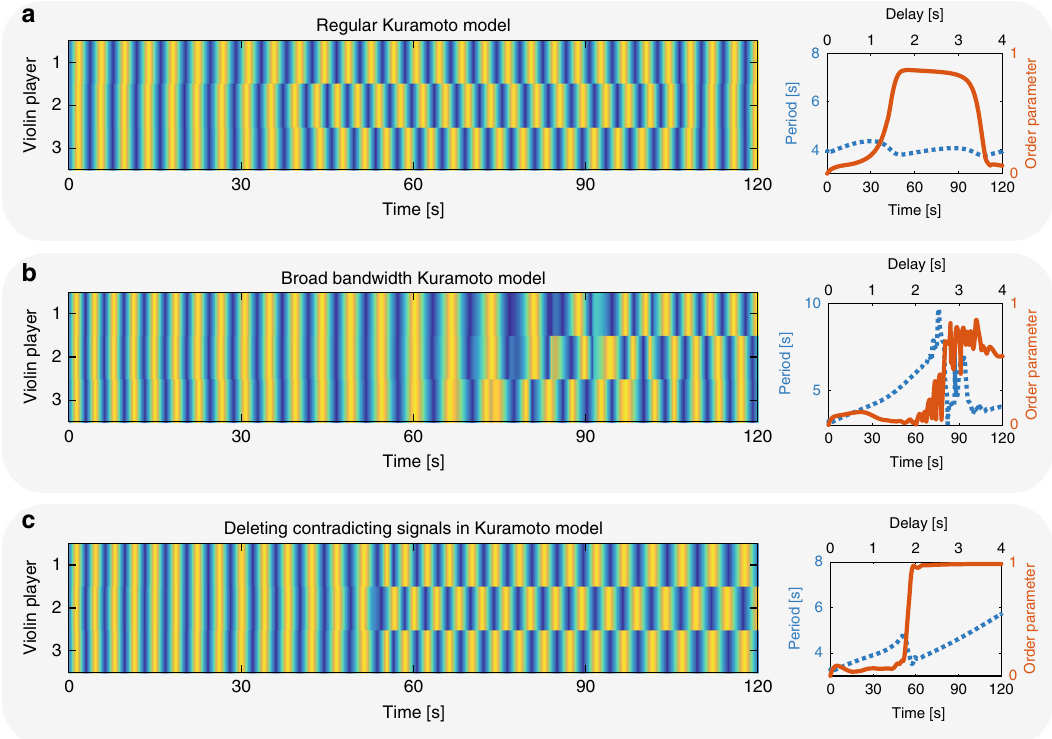
Fig. 9 Calculated results of three coupled violin players. a Regular Kuramoto model showing that the players can only reach a partial state of out-of-phase synchronization and cannot stay in that state when increasing the delay. b Broad-bandwidth Kuramoto model showing that the players can stay in the partial out-of-phase state of synchronization, but it is not stable due to frustration. c Broad-bandwidth Kuramoto model where each player can choose which connections to ignore. Here the players fi nd the state of out-of-phase synchronization and remain in it while increasing the playing period. We calculate the order parameter in this situation according to the connections which the players are choosing to